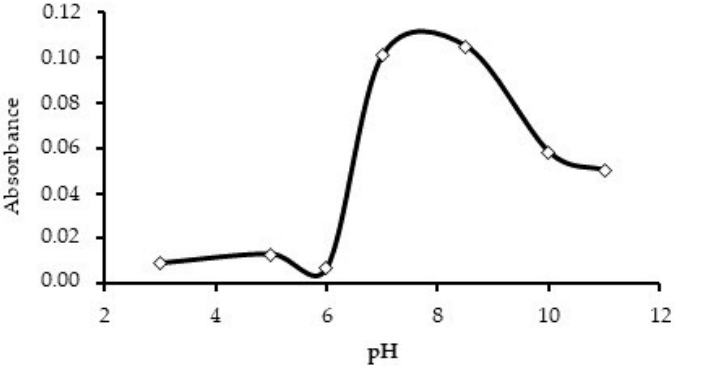
Figure 4. Effect of different pH levels on the sensor absorbance’s response for solution containing 2 mg L −1 Ni 2+ in fixed time (10 min).